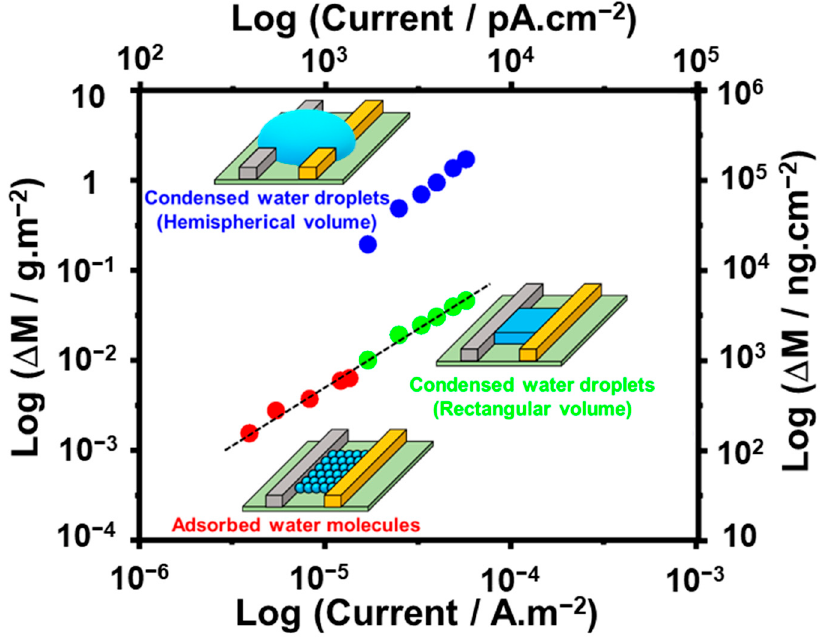
Figure 5. Correlation between the mass of adsorbed water molecules (red color) or the mass of condensed water droplets based on hemispherical model (blue color) or rectangular model (green color) that were detected on the MSC surface with their detected current density.